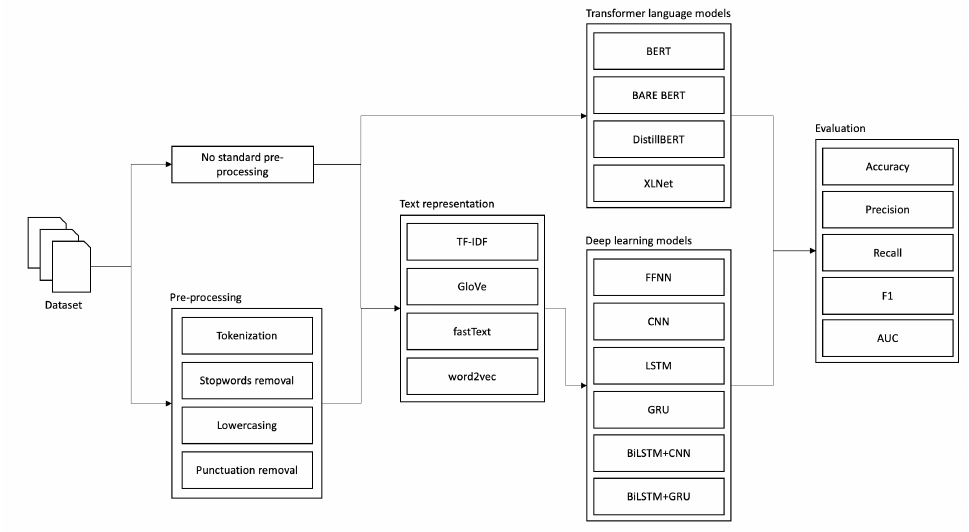
Figure 9. Overall schema of the experiments setup.